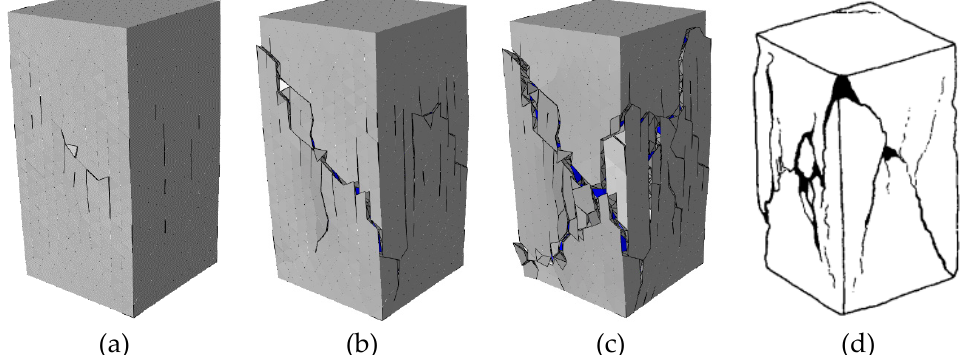
Figure 22. Fracture pattern (aggregate in blue and cement matrix in gray) of the concrete specimen with 200 mm height at different states in Figure 20: ( a ) state A, ( b ) state B, ( c ) state C, and ( d ) the final fracture pattern in experiments [46].